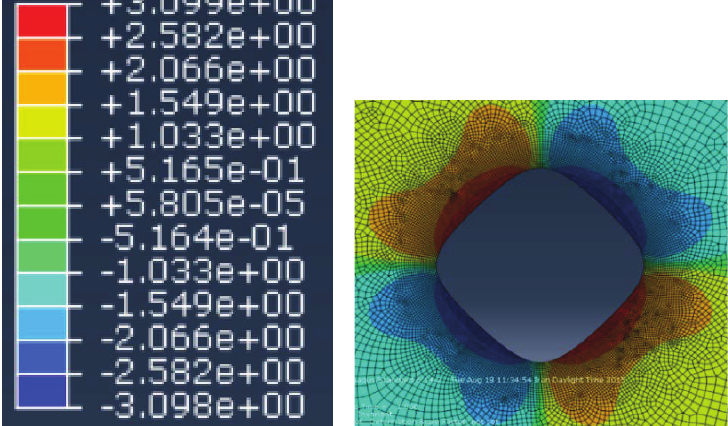
Figure 8. Stress distribution around quasi-square cut out obtained from FEM ( θ 3 = 90 ◦ and w =